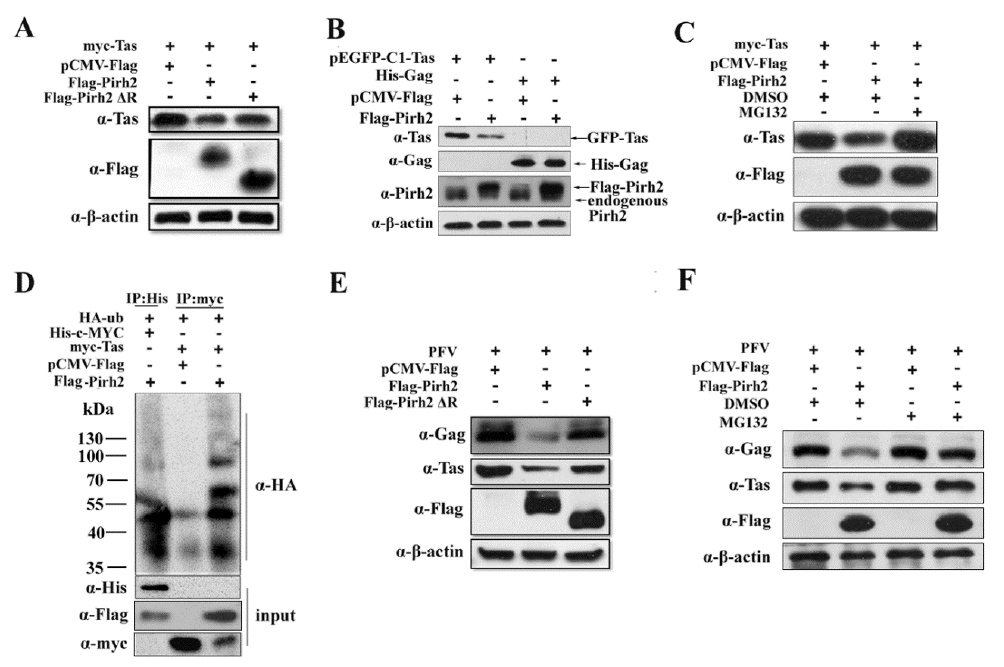
Figure 5. Pirh2 decreases the expression of Tas protein and inhibits PFV replication through ubiquitin-proteasome pathway. ( A , E ) Tas expression or PFV replication are down regulated by overexpressed Pirh2 and deletion of RING domain abrogates its inhibitory effect; ( B ) Pirh2 down regulates Tas specifically. 293T cells were transfected Flag-Pirh2 with pEGFP-C1-Tas or His-Gag, and Western blot was used to detect the expression of Tas or Gag; ( C ) Pirh2 down regulates the expression of Tas protein and the inhibition was reversed by MG132. myc-Tas combined with Flag-Pirh2 or pCMV-Flag (as control) were transfected